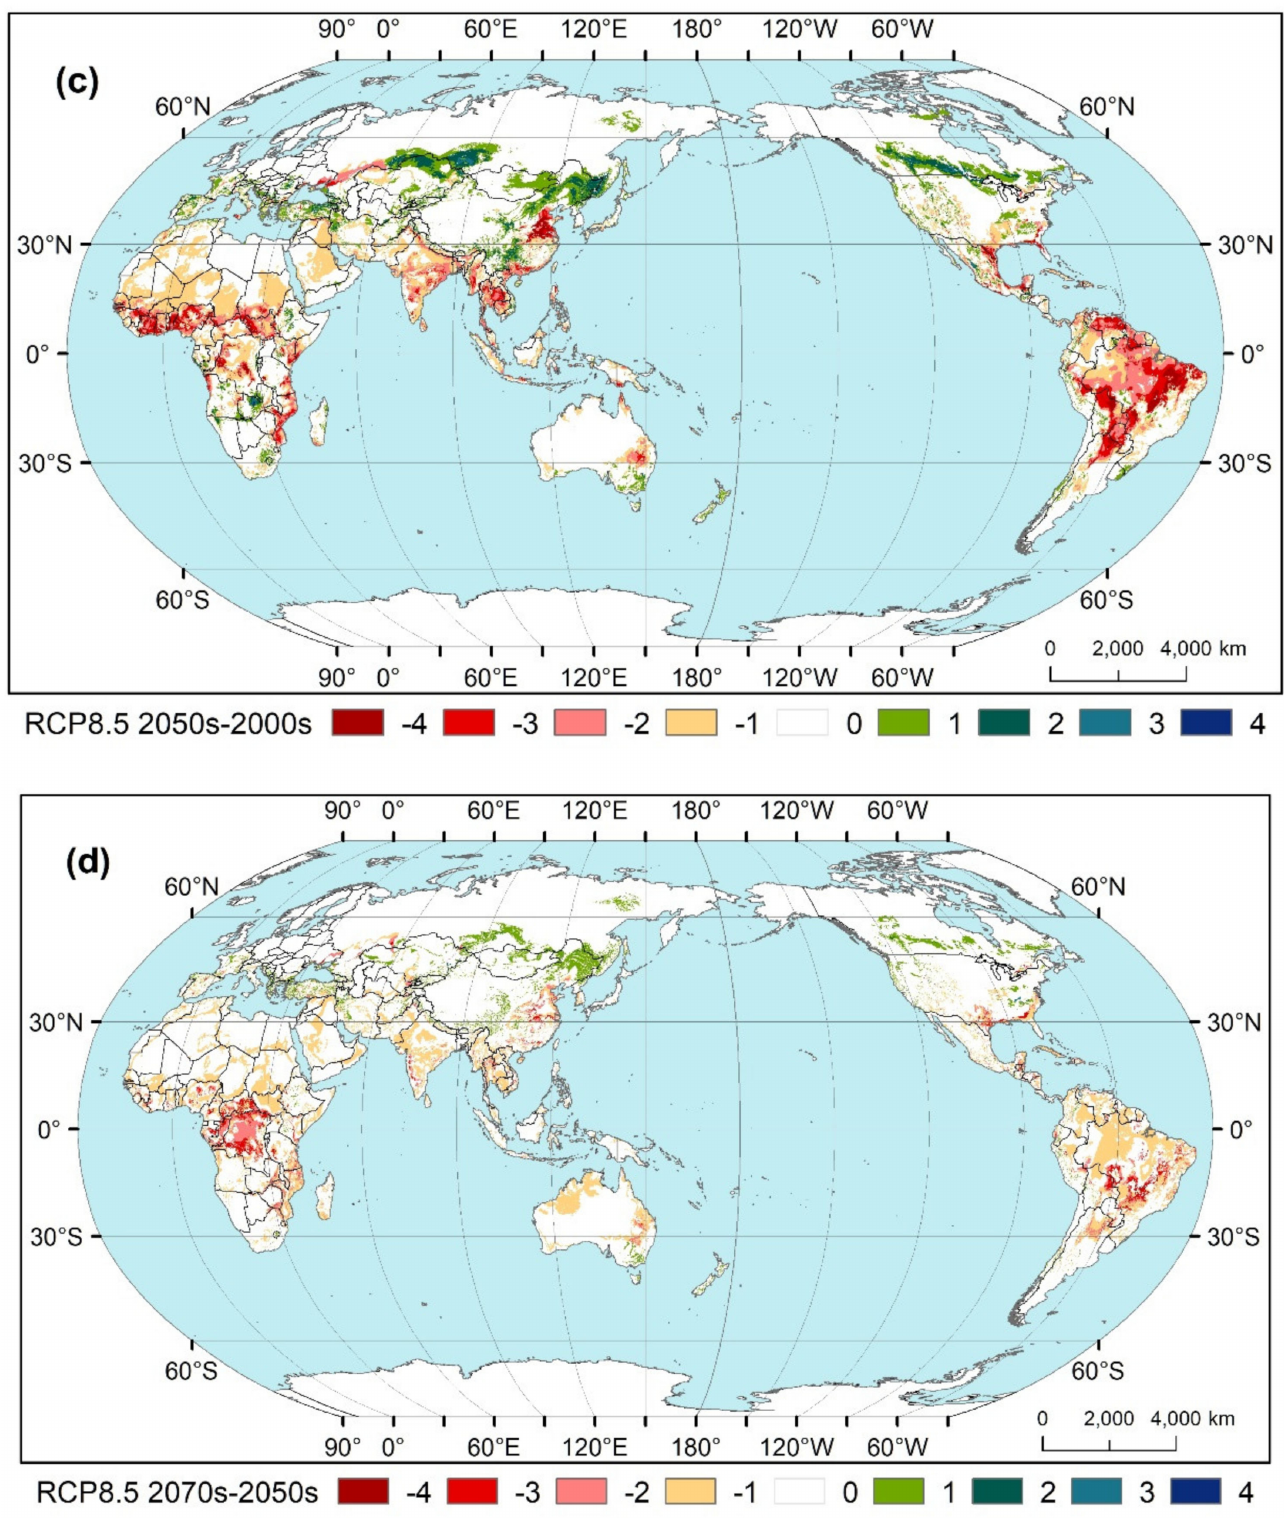
Figure 5. Changes in worldwide land suitability for maize cultivation between different periods under the same RCPs. ( a ) 2050s (2041–2060) relative to that in the past (1970–2000), under RCP2.6; ( b ) 2070s (2061–2080) relative to 2050s, under RCP2.6; ( c ) 2050s relative to the past, under RCP8.5; ( d ) 2070s relative to 2050s, under RCP8.5. RCP: representative concentration pathway. Note: The numbers indicate increases (positive) or decreases (negative) in the level of